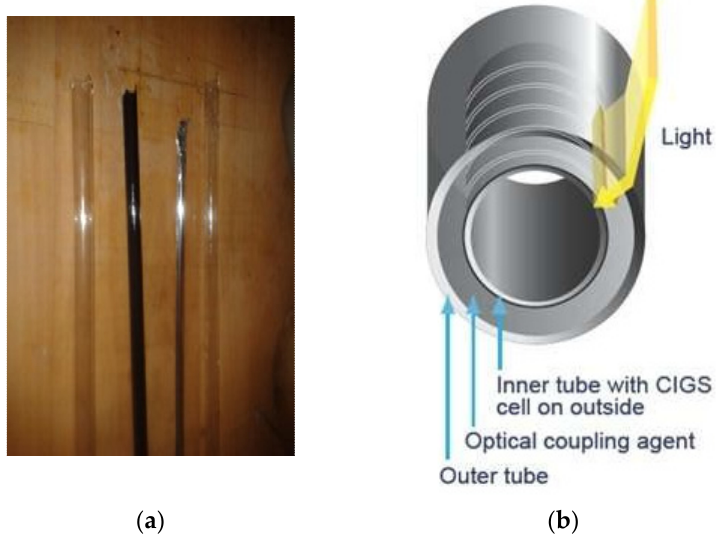
Figure 2. Solar collector glass tube (ST): ( a ) waste solar collector glass tube used after grinding as the filler in the coating; ( b ) section of a tubular solar panel [32].